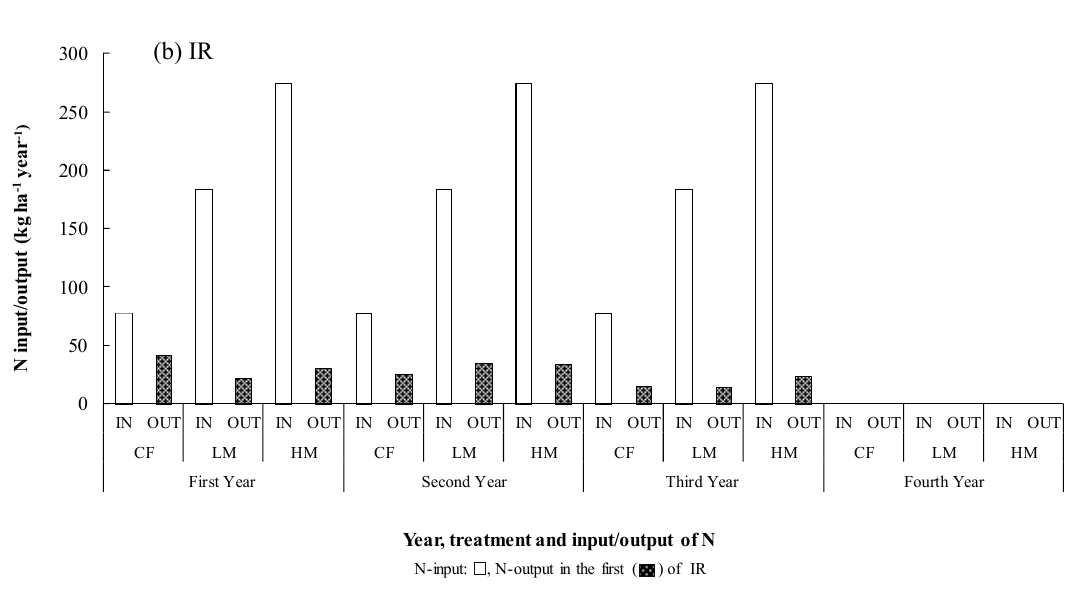
Figure 3. Input (IN) and output (OUT) of nitrogen (N) from defoliation of ( a ) DL Napiergrass and ( b ) Italian ryegrass (IR). For abbreviations of treatments and years, refer to Figure 1.